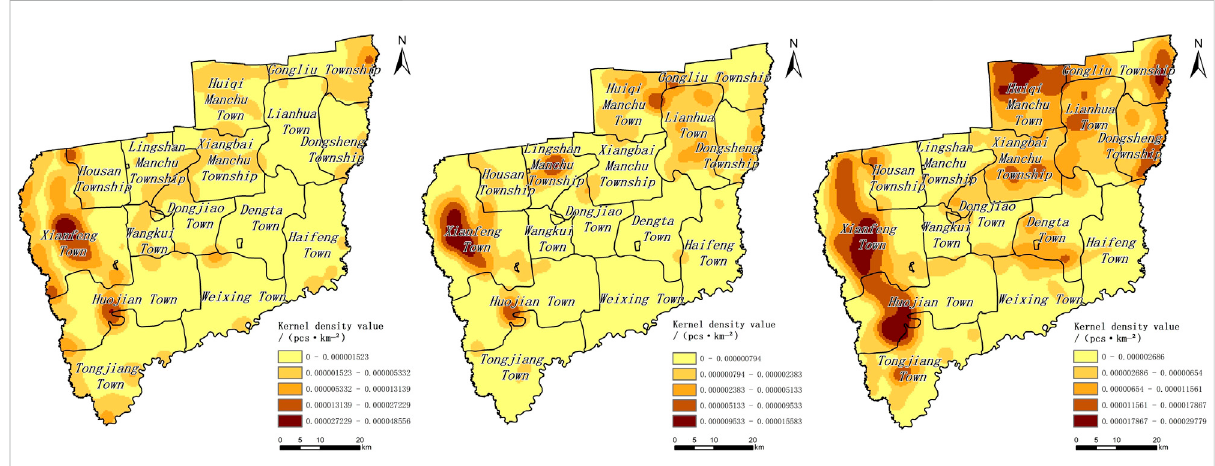
FIGURE 10 Spatial distribution characteristics and evolution of rice – soybean rotation